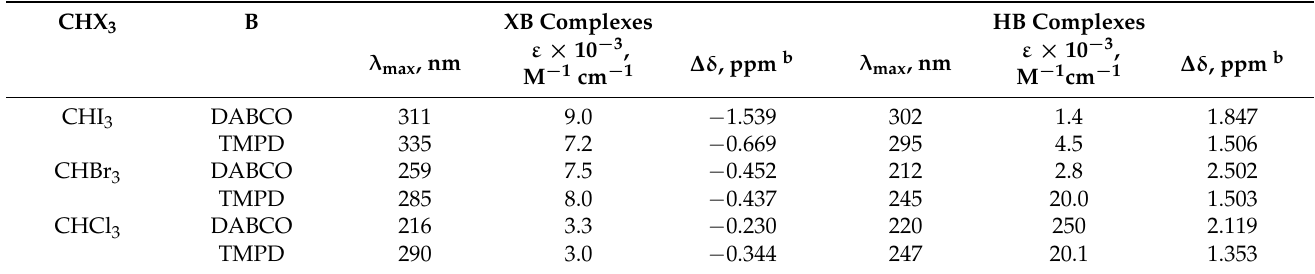
Table 3. Calculated UV–Vis and NMR characteristics of the XB and HB complexes a .